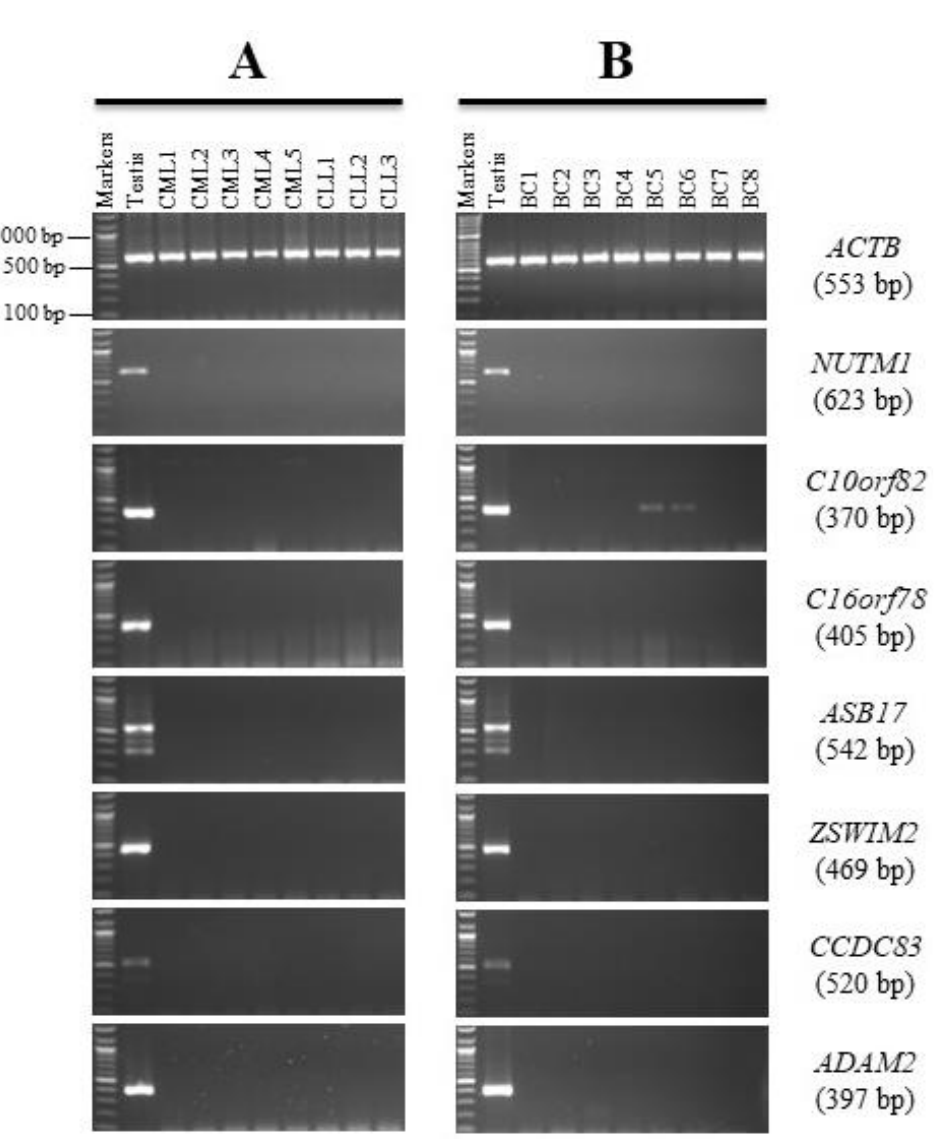
Figure 5. RT-PCR expression profiles for the meiotic restricted genes in leukemia and breast cancer (BC) tissues. Agarose gels display the RT-PCR analysis for the NUTM1, C10orf82, C16orf78, ASB17, ZSWIM2, CCDC83, and AMAM2 genes. ( A ) cDNAs were synthesized from the total RNA from eight leukemia cancer (chronic myeloid leukemia (CML), and chronic lymphoblastic leukemia (CLL)). ( B ) cDNAs were synthesized from the total RNA from breast cancer (BC) tissues. ACTB expression was used as a positive control for the cDNA samples. Testis cDNA was used to test the primer for each gene. The expected product size of each gene is presented on the right between brackets.